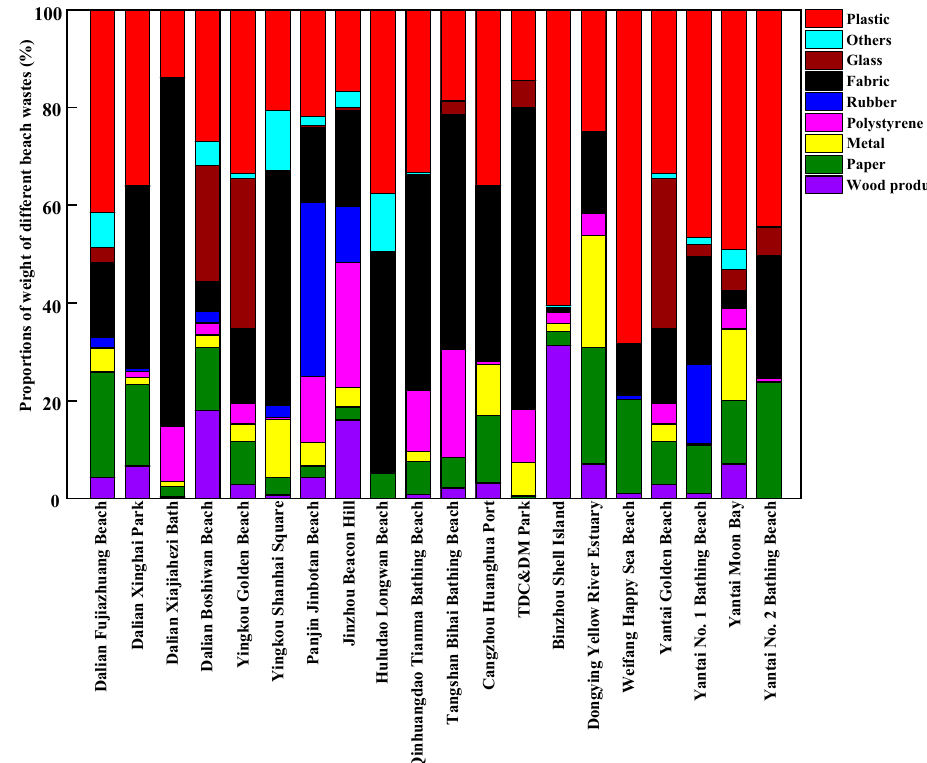
Figure 5. The proportions of different components of beach waste in coastal cities around the Bohai Sea of China in the tourist peak season, by quantity.